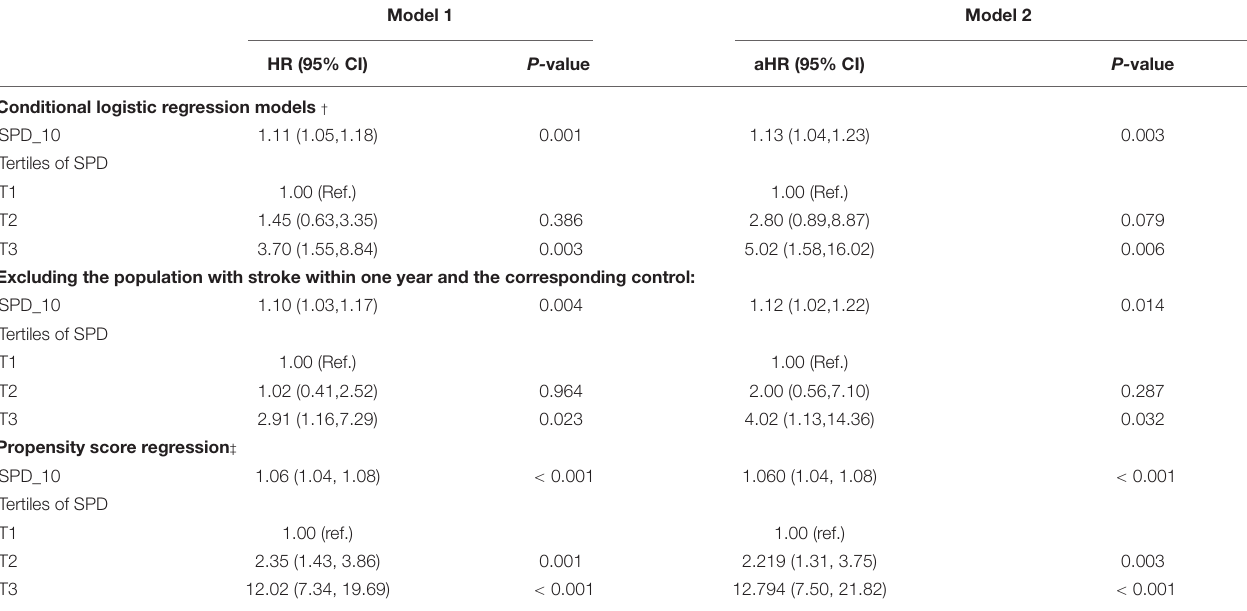
TABLE 2 | Relationship between serum spermidine levels and stroke in prospective and retrospective case-control study.